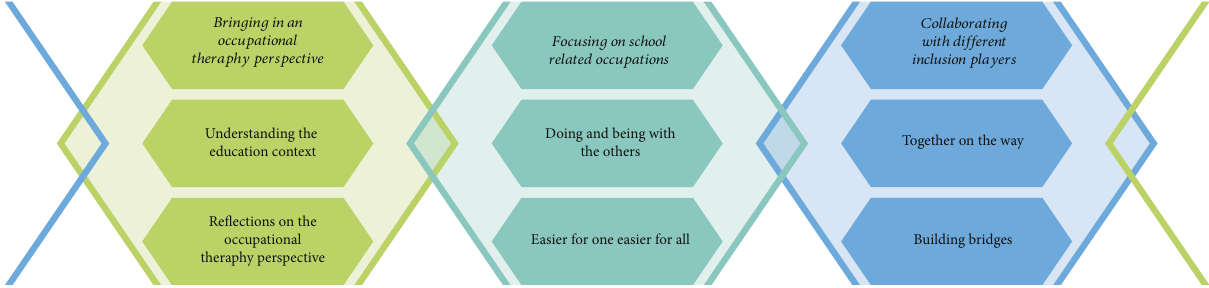
Figure 1: Visual illustration of the themes and related